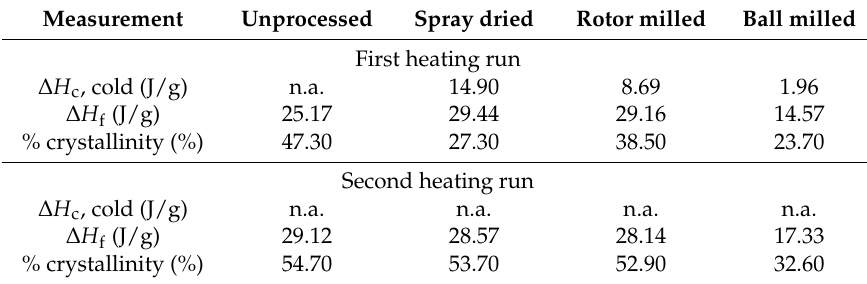
Figure 7. Thermograms representing the second heating runs of the processed samples: ( A ) unprocessed; ( B ) ball milled for 15 min; ( C ) spray dried at optimal conditions; ( D ) rotor milled after final sieving step. Table 3. Enthalpy values calculated from the thermograms in Figures 6 and 7 with the resultant percentages of crystallinity calculated according to Equation (1).